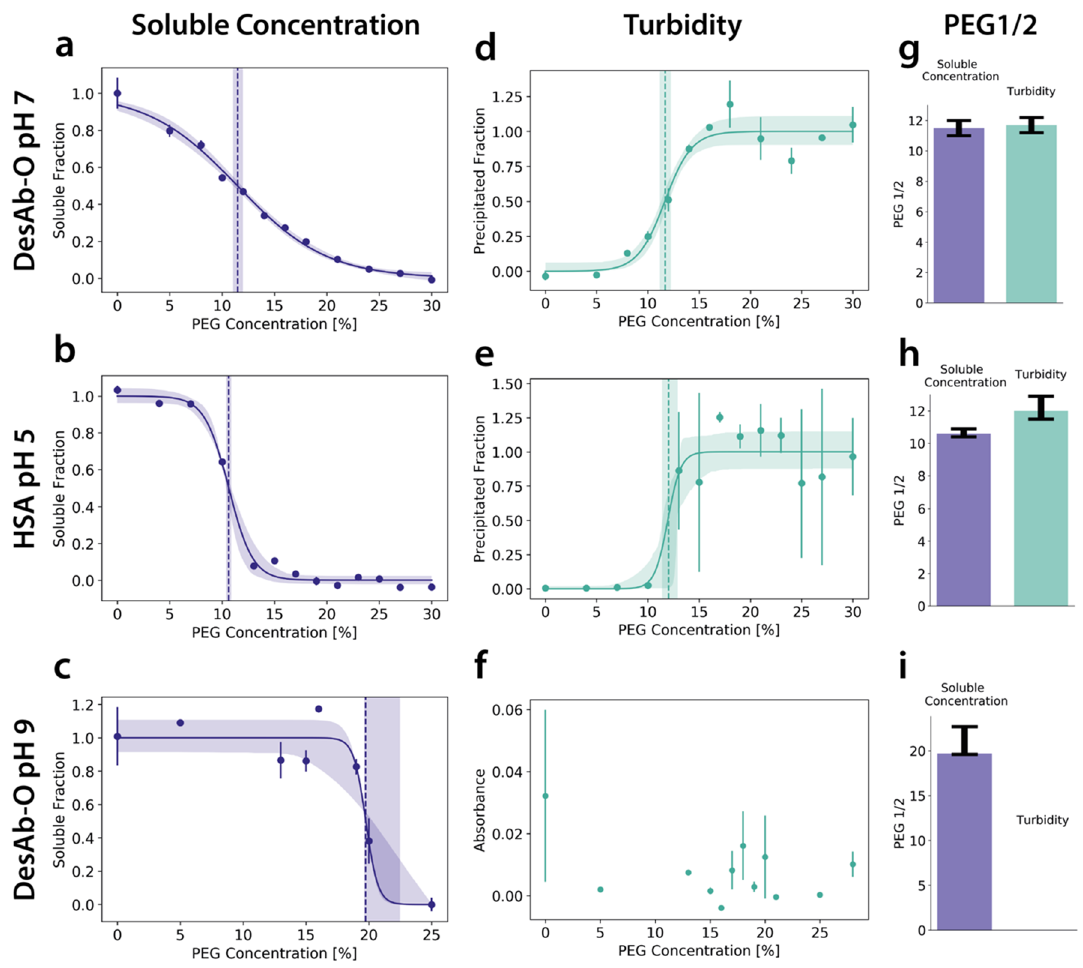
Figure 5. To quantify soluble concentrations, supernatant absorbance measurements are more consistent than turbidity measurements. (a–c) Absorbance measurements of soluble fractions after transfer of the supernatant . (d–f) Turbidity measurements of the same run taken before centrifugation. (g–i) Bar plots comparing the PEG 1/2 values for absorbance of the soluble concentration and turbidity. ( a, d, g) PEG 1/2 values for both approaches agree for DesAb-O at pH 7. ( c, e, h) For HSA at pH 5, PEG 1/2 values are affected by small errors ( b, h) , while the turbidity shows a later onset of the precipitation and has larger error bars across technical replicates. (e, h) . (c, f, i) While absorbance measurements show a clear drop at around 20% PEG for DesAb-O at pH 9, indicating that the protein is precipitating, the turbidity measurement data do not reliably detect changes because of the high level of